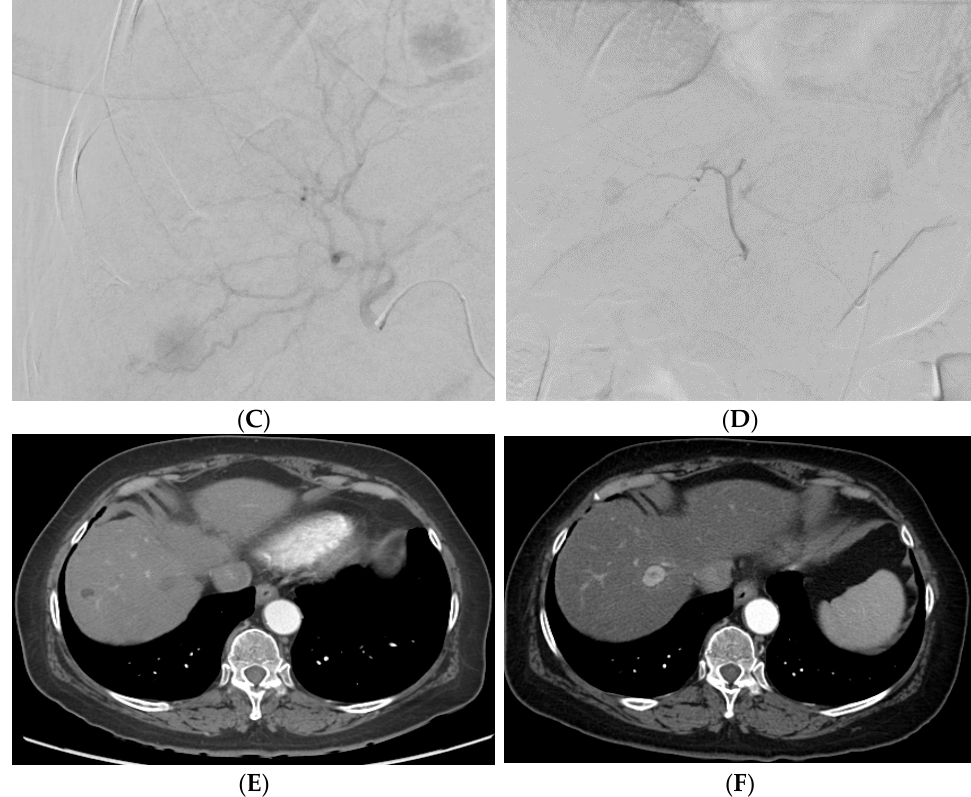
Figure 4. A patient with multifocal HCC who underwent DEB–TACE for its management. CT showing multifocal HCC involving the right ( A ) and left lobe ( B ). Common hepatic artery angiogram showing tumor blush ( C ), which completely disappeared after DEB–TACE ( D ). Follow-up CT showing good tumor response in the right ( E ) and left ( F ) lobe of the liver.